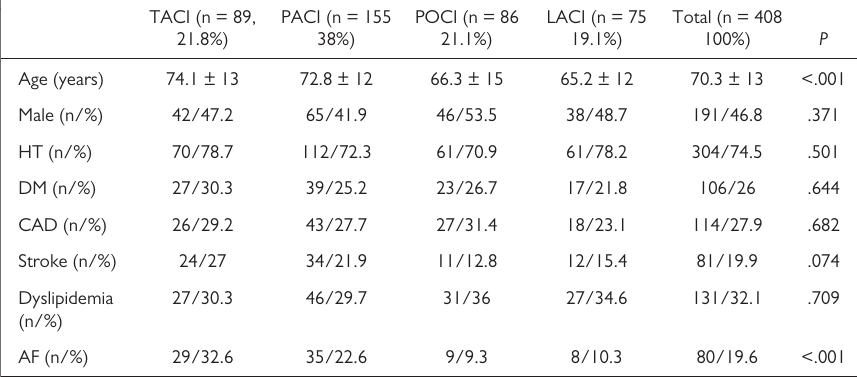
Table 2. Demographic Findings of Ischemic Strokes according to